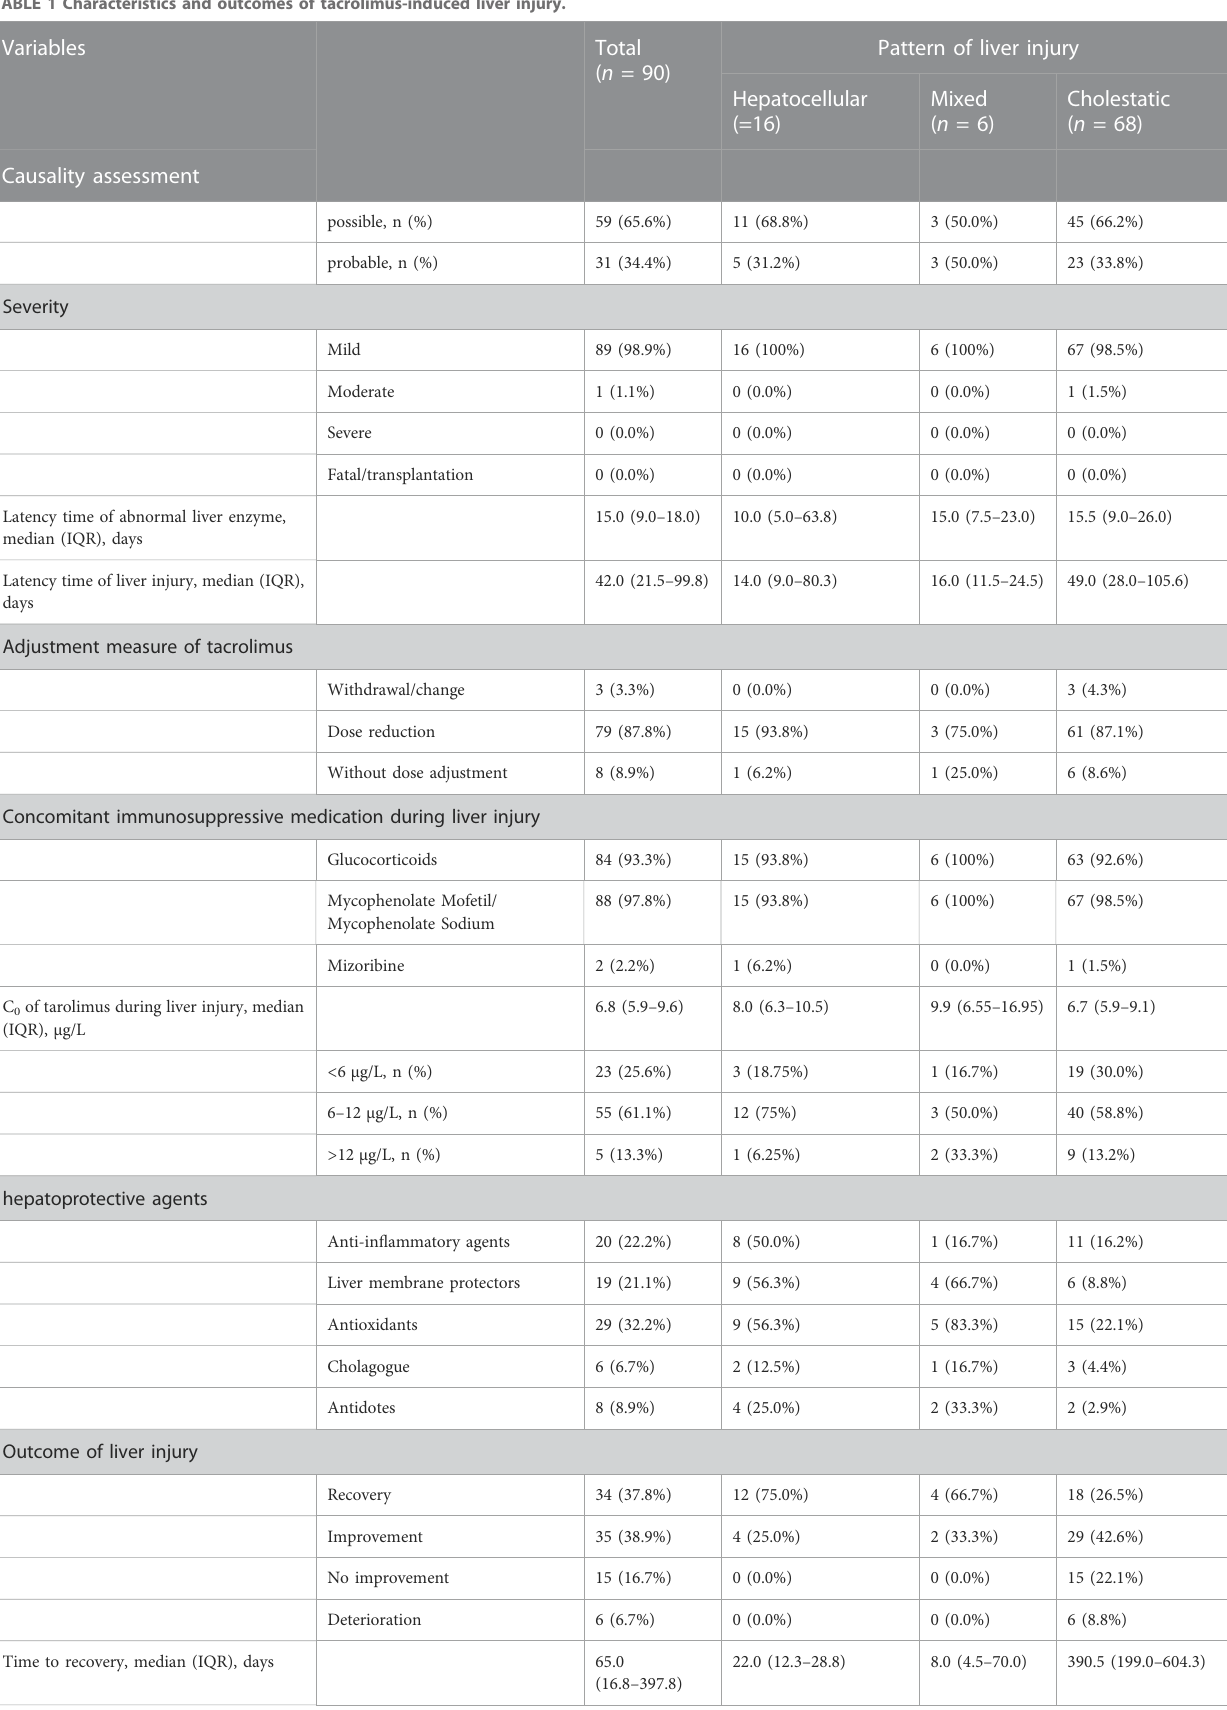
TABLE 1 Characteristics and outcomes of tacrolimus-induced liver